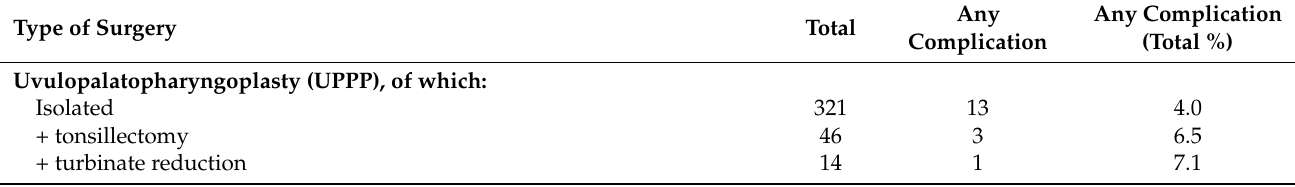
Table 5. Distribution of procedures with the type-specific occurrence of any